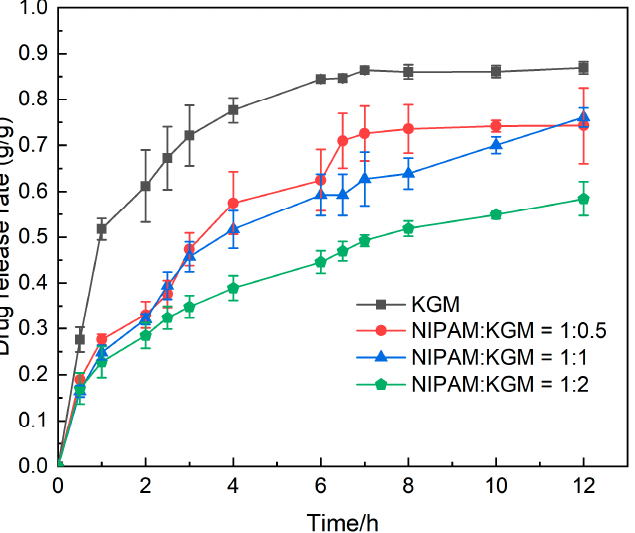
Figure 5. This picture shows the drug loading of hydrogels with different ratios under the same